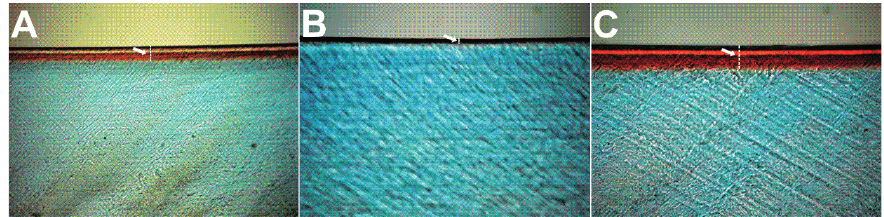
Figure 4- Polarized light microscopy photomicrographs (40x) of enamel lesions in each group after submitted to an artificial cariogenic challenge. Artificial carious lesions - areas of demineralization (arrows: negative birefringence areas); A- control group; B- 1000 ppm NaF; C- GSE